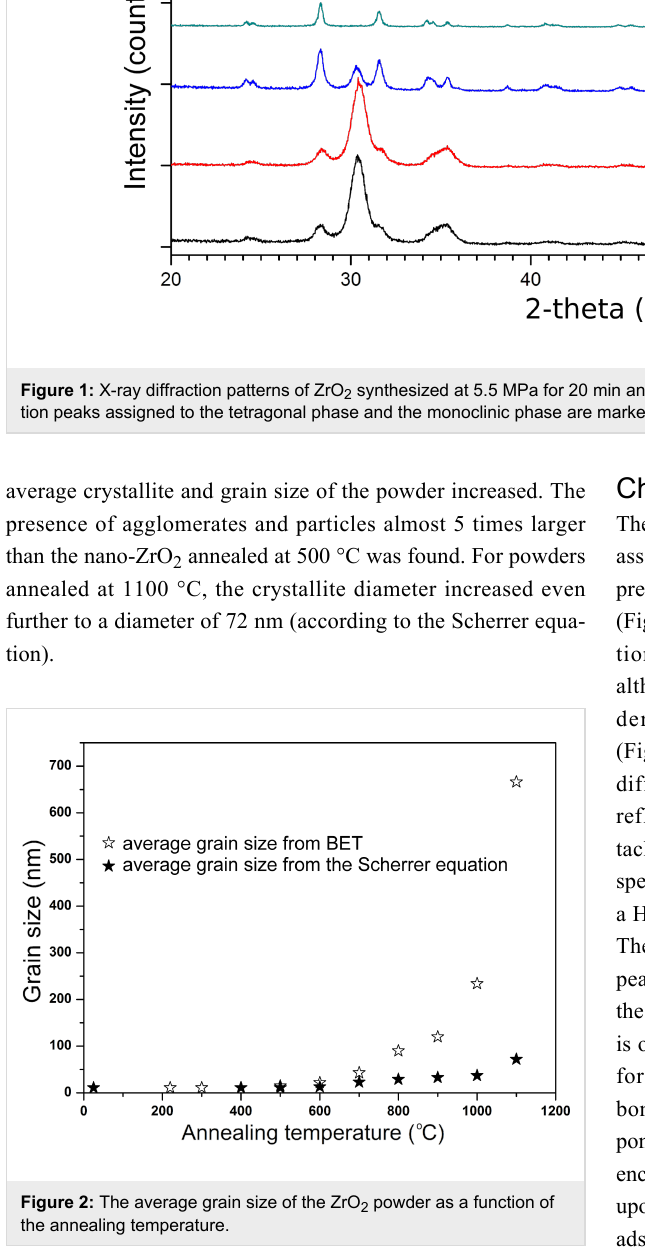
The increase in the ZrO 2 grain size with increasing annealing temperature was also clearly visible in SEM images (Figure 3). The grains were predominately spherical and tended to form agglomerates (Figure 3C). The much higher apparent particle size is the result of particle